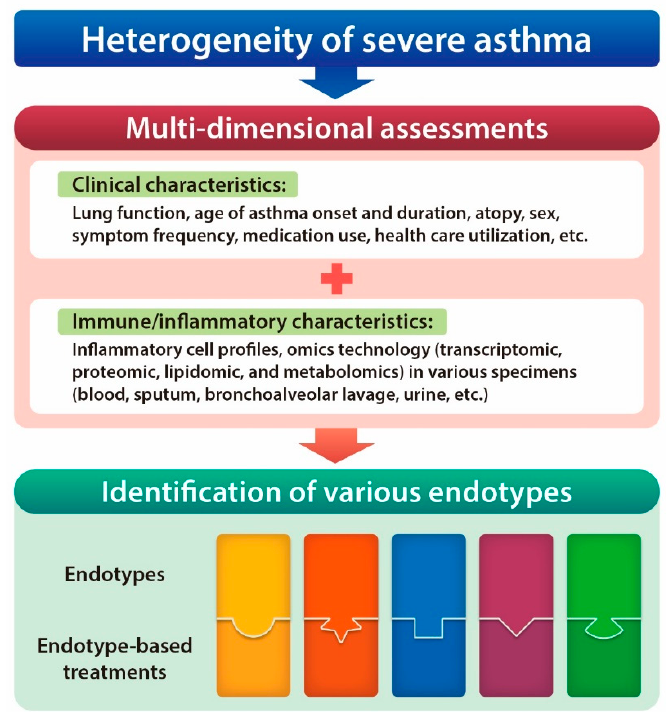
Figure 1. Multi-dimensional approaches involving both clinical characteristics and immune/inflammatory profiles are required for proper identification of diverse endotypes and subsequent development of endotype-based treatments in heterogeneous severe asthma.